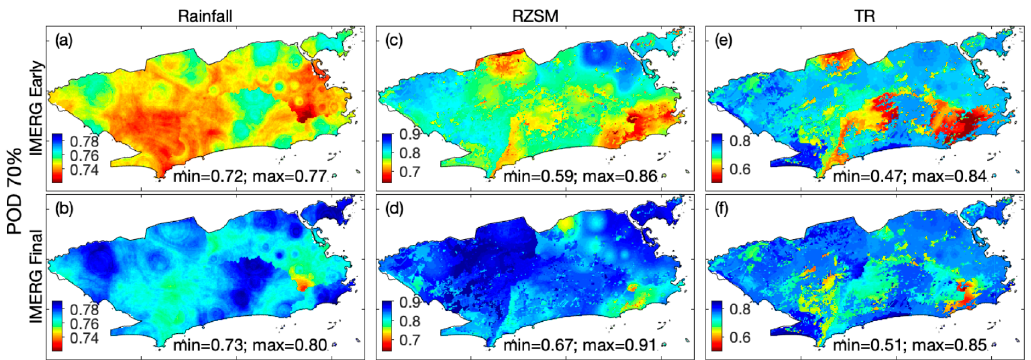
Figure 7. Selected storm events in Rio de Janeiro city and impacts on total runoff (TR) and rootzone soil moisture (RZSM) over urban (top) and landslide ‐ prone (bottom) areas. Left panels show the evolution of the storm occurred from 5–7 February 2019 (Event 1), and right panels show the storm that occurred in 9–10 April 2019 (Event 2). Results are shown at the hourly time step and x ‐ axes indicate days of the month.